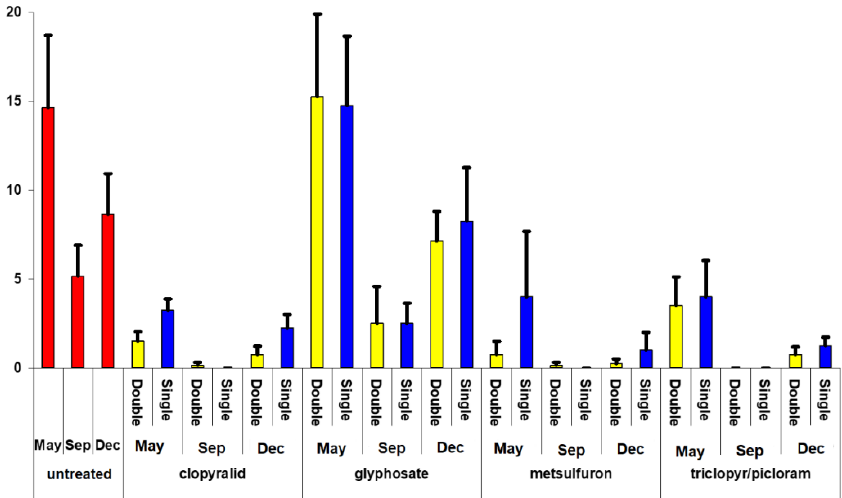
Figure 2. The clover composition of plots after herbicide application by a wiper in January. (Vertical bars refer to standard error of the mean, n = 4). Table 4. Injury scores to pasture clovers and grasses for a double pass 5 weeks after application of herbicides, where 1 = total mortality and 10 = no effect.